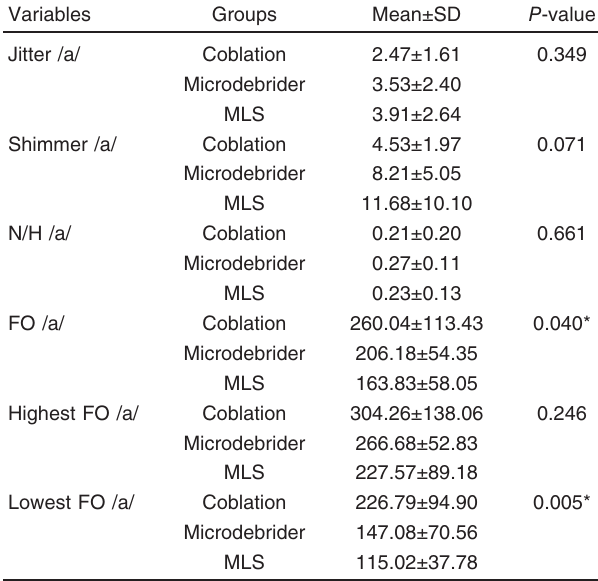
Table 3 Comparison between the three groups regarding baseline data of computerized speech lab. /a/ (preoperatively)